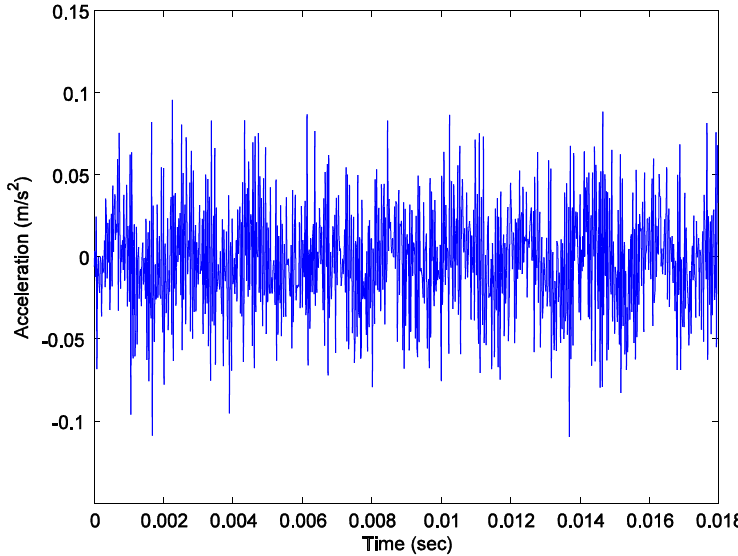
Figure 6. Vibration data points of a roller-bearing in healthy condition